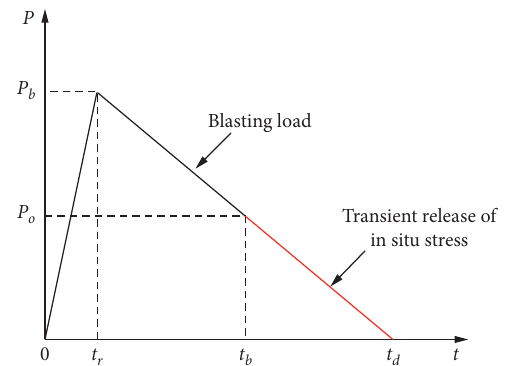
Figure 8: Coupling effect curves of blasting load and transient release of in situ